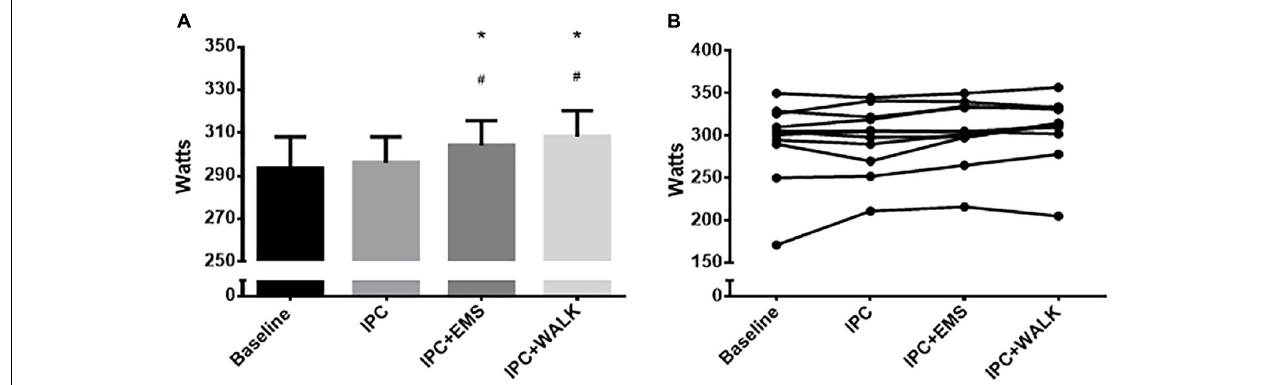
FIGURE 3 | (A) Mean peak watts from the incremental maximal aerobic test for each intervention and baseline. Data is presented as mean ± SE and the differences were considered significant at P ≤ 0.05. ∗ Represents statistically different from baseline; # Represents statistically different from IPC alone. (B) Individual peak watts from the incremental maximal aerobic test for each intervention and